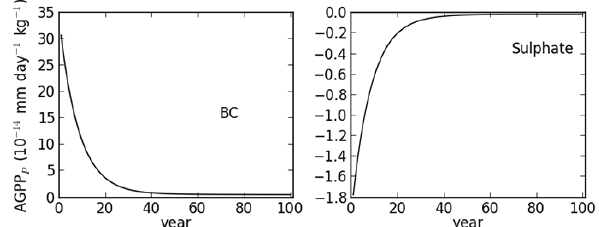
Figure 2. AGPP P for 1kg pulse emissions of black carbon (BC) and sulphate. Note that the RF term in Eq. (3) is negligible for such short-lived gases, except at time horizons less than a few weeks, and only the total is shown.